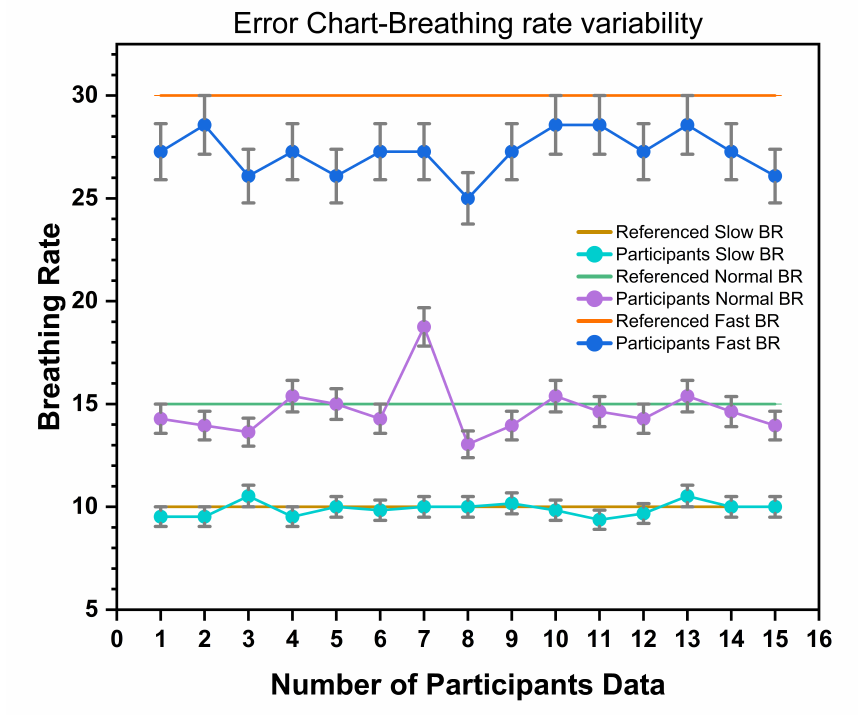
Figure 19. Breathing − rate (BR) variability and error analysis for 15